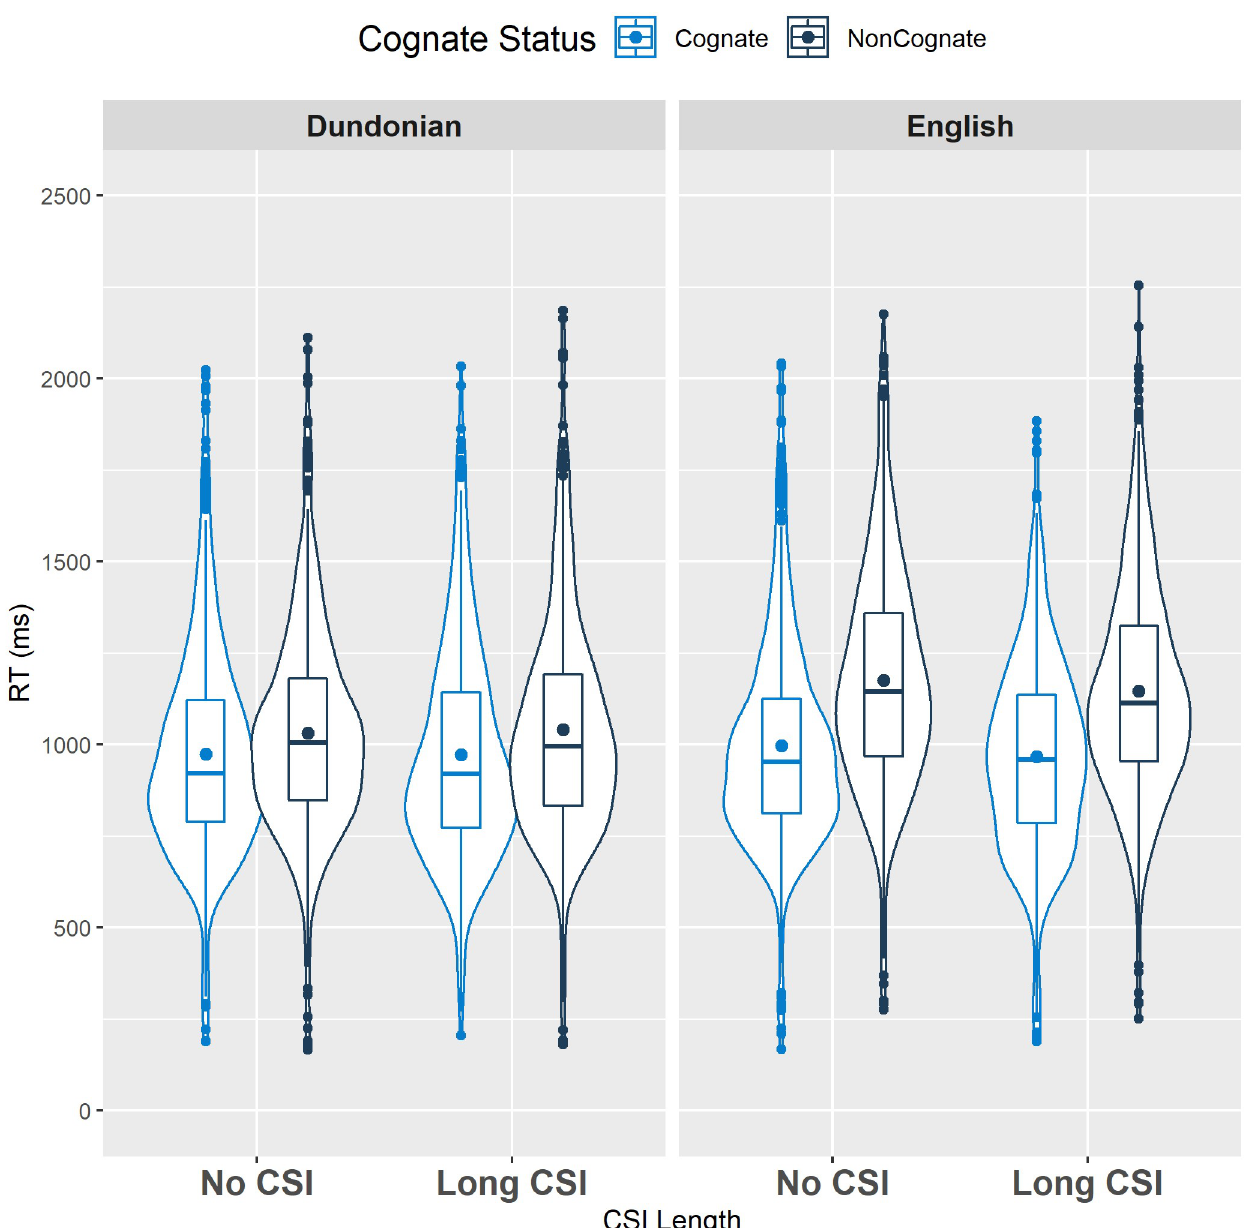
Fig 2. Violin plot showing the distribution of cognate and non-cognate RTs in each CSI block across both varieties for Experiment 2 (Dundonian/ English “bidialectals”). The boxplots show the interquartile range, the horizontal line represents the median, and the dot indicates the mean for each